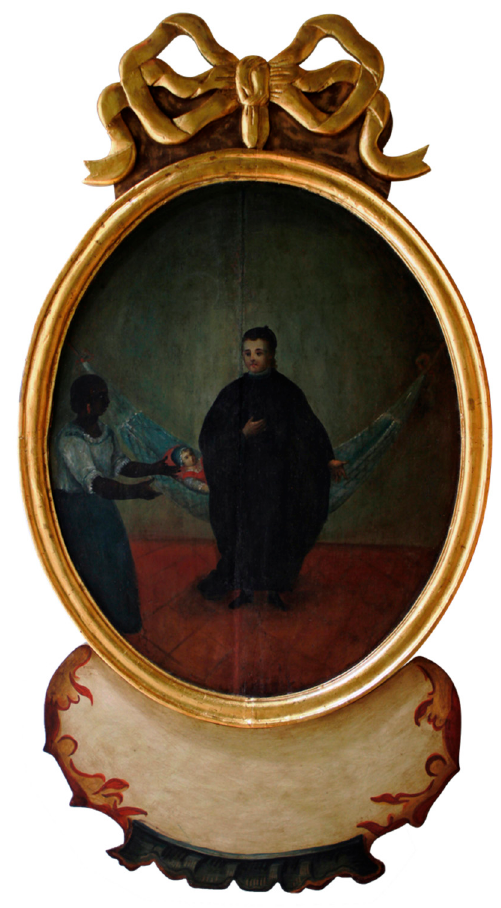
Figure 6. Child asphyxiation accident , c. 1760–1778, oil on panel, Museo de Altagracia, Higüey, Dominican Republic. Used with permission from Museo de Altagracia.